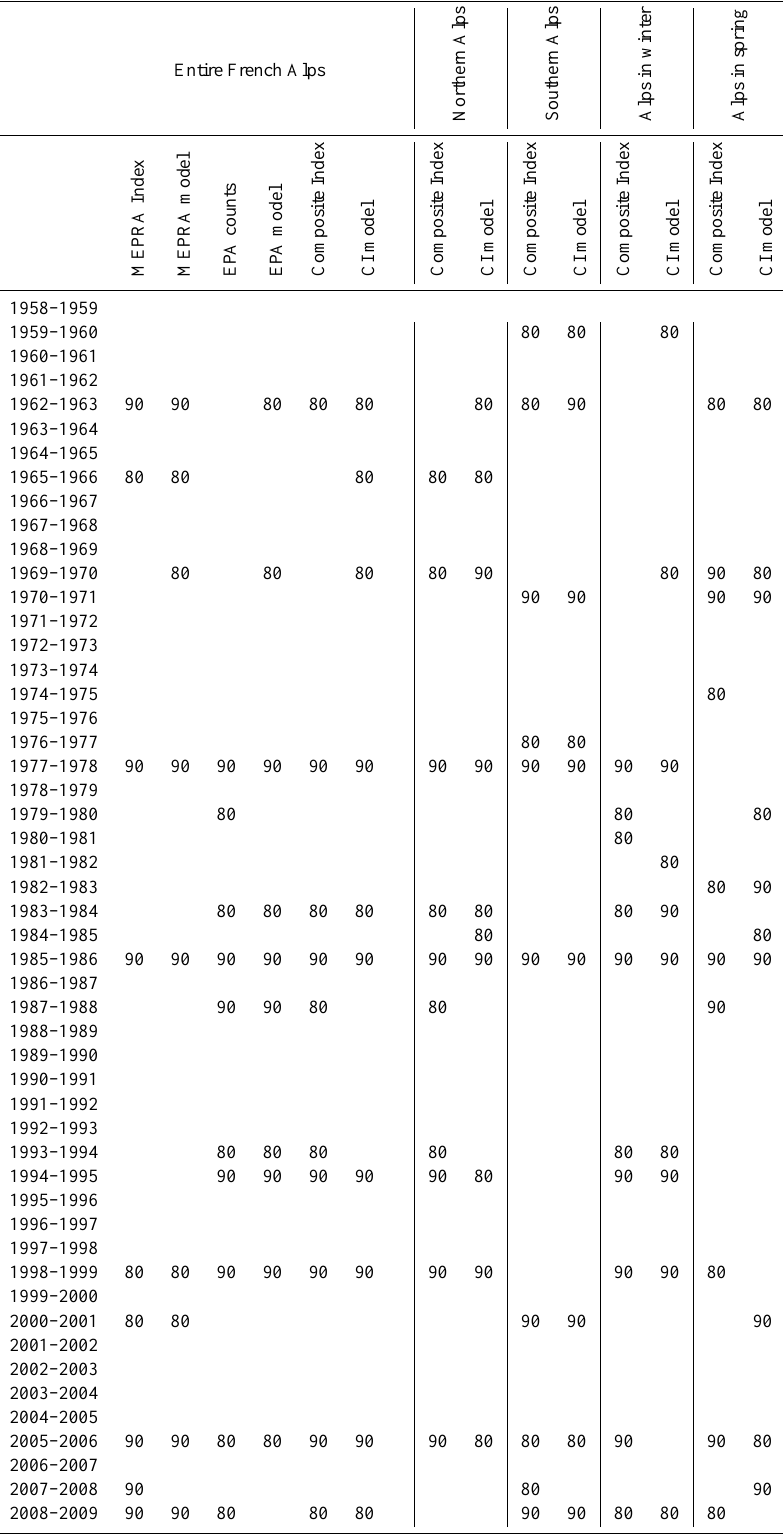
Table 2. Avalanche years for which response variables and associated regression models exceed an 80th or a 90th percentile threshold (marked as 80 and 90,